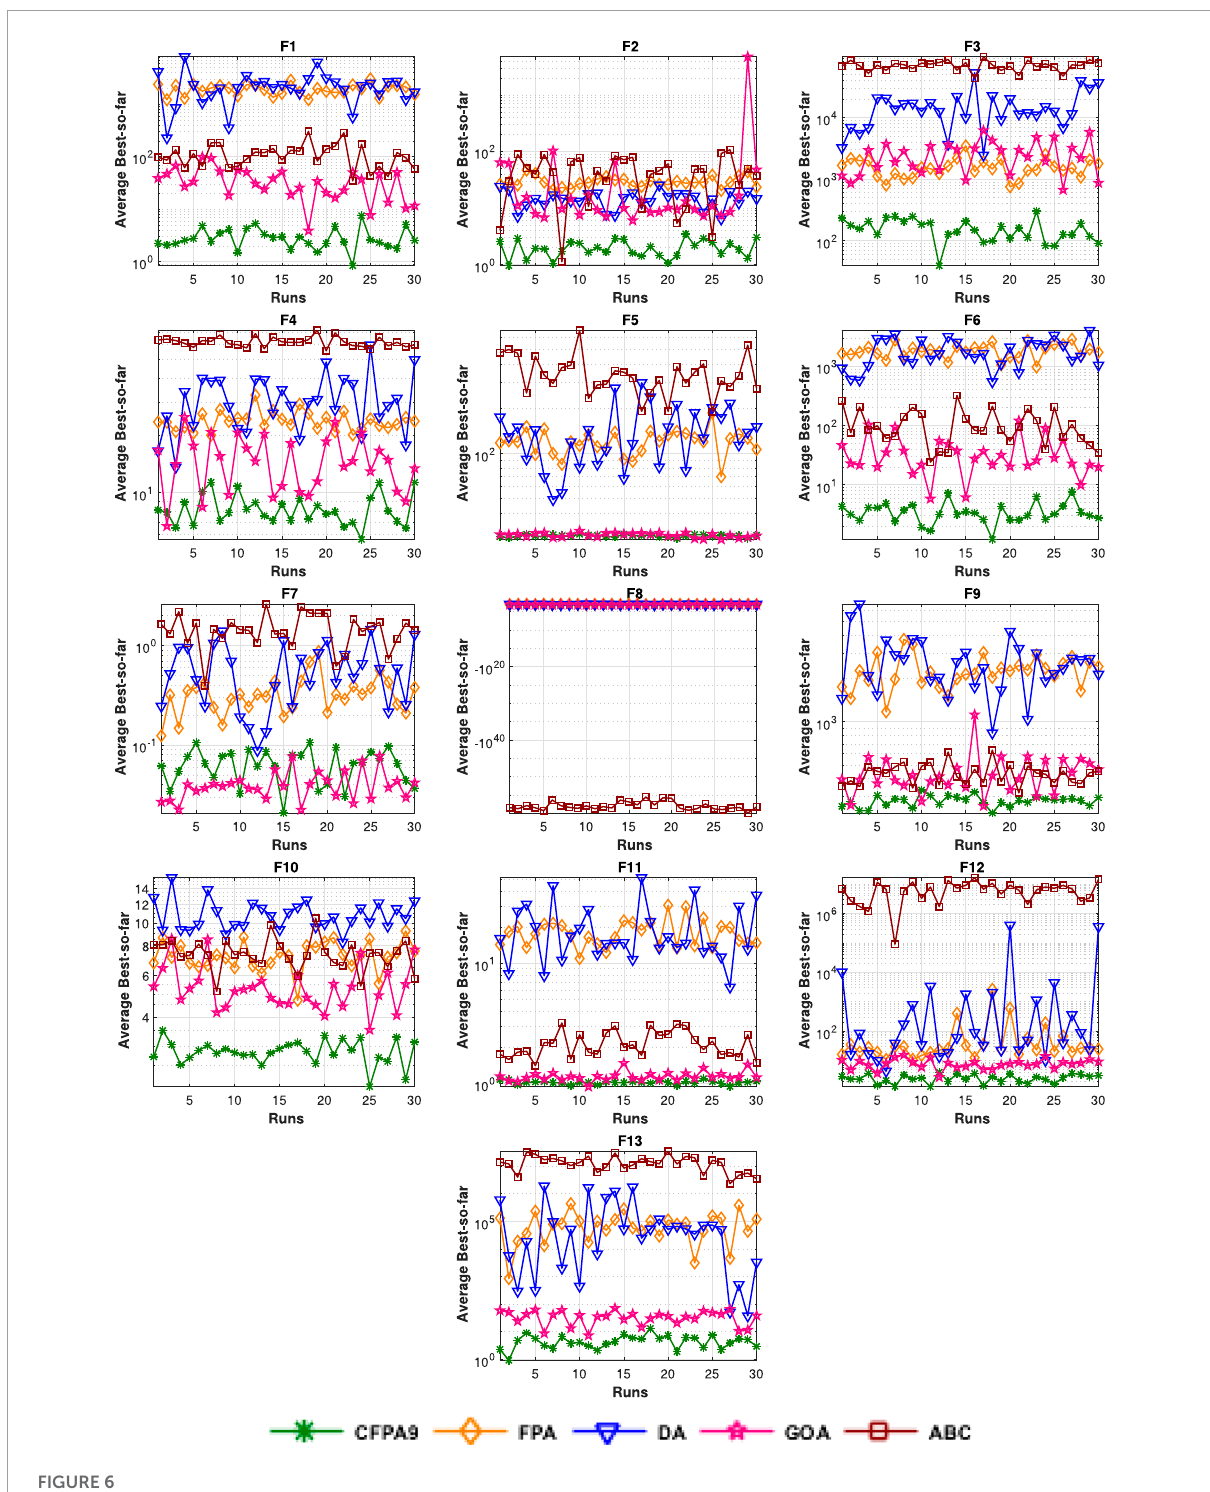
FIGURE 6 Runs of best CFPA9 versus well-known